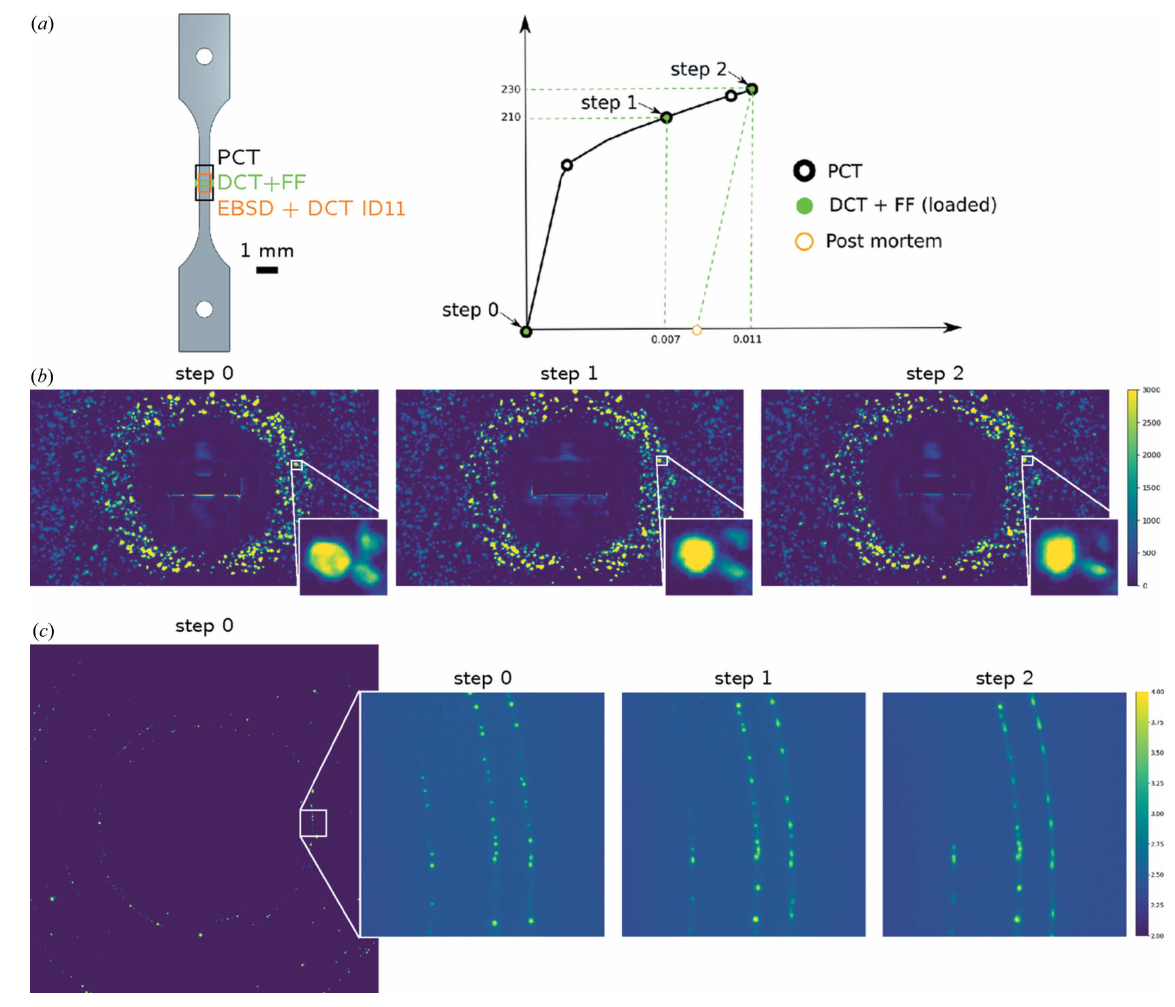
Figure 3 In situ experimental overview: ( a ) specimen geometry showing the different acquisition zones and loading curve, ( b ) near-field images integrated over 5 (cid:2) showing the diffraction spots acquired during DCT scans at each step (the insets show a zoomed-in view of a given location), ( c ) ff-3DXRD single frame image and zoom on a given detector zone showing 1 (cid:2) integrated images at each load step (logarithmic scale has been